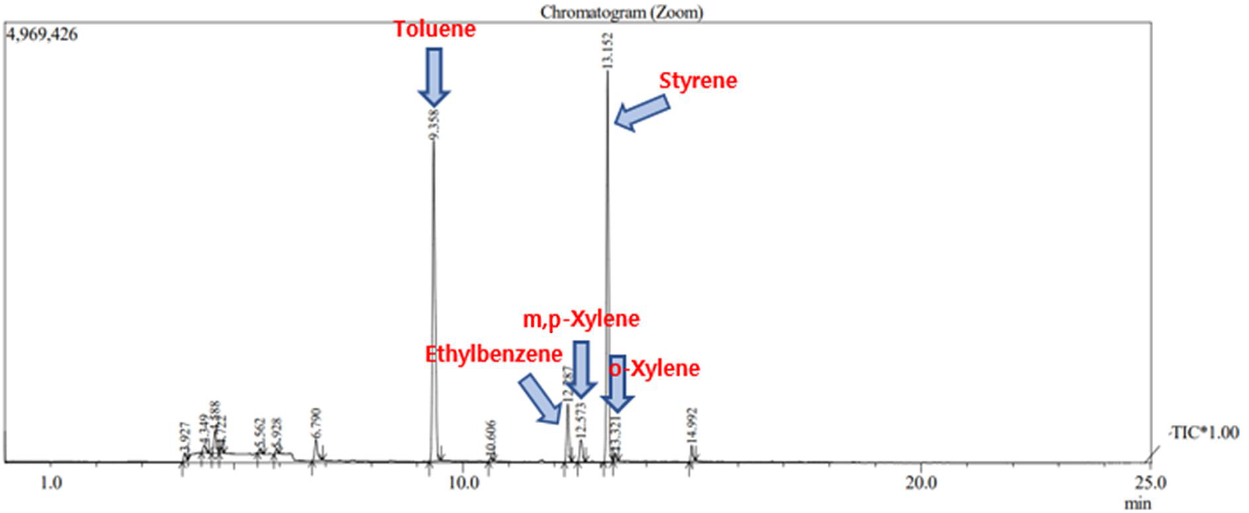
Figure 10. The chromatogram analyzing the 10–11 am measurement point, the measuring point 4 of Business site B. Table 7. VOC speciation concentration by businesses A and B.